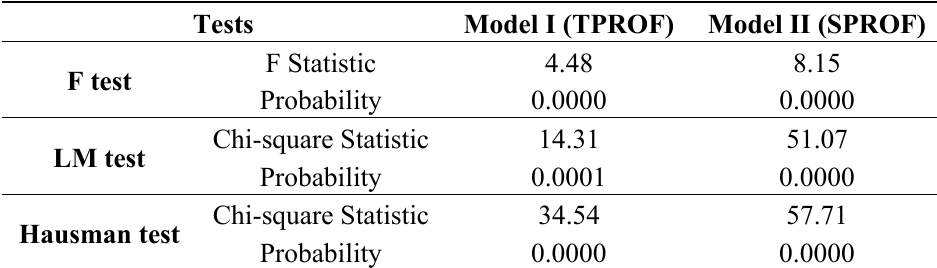
Table 5. The results of F, LM and Hausman